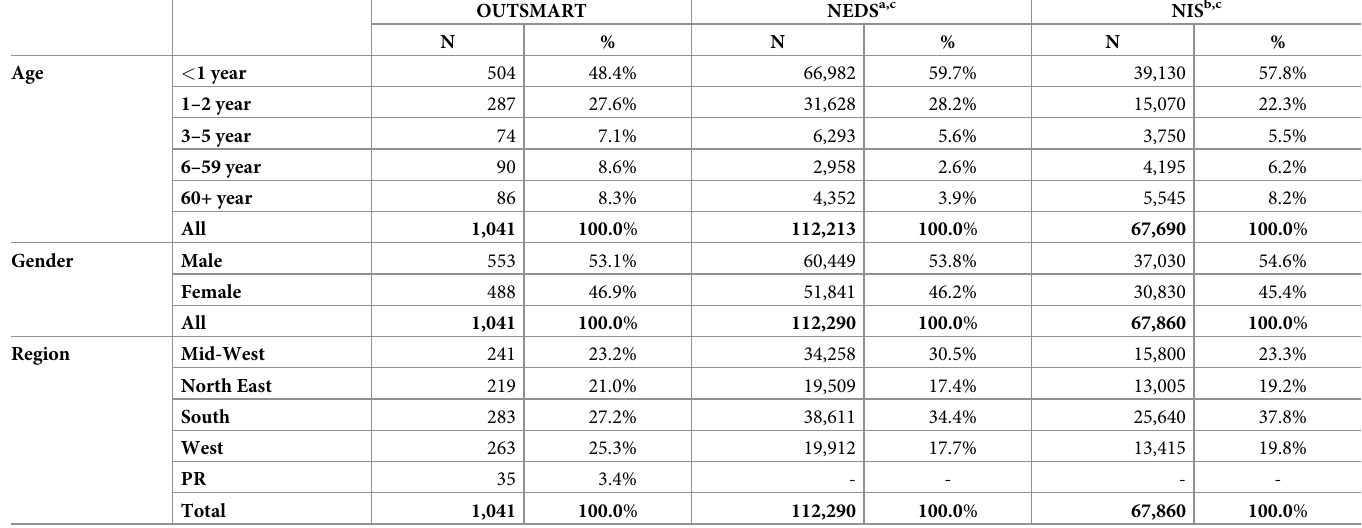
Table 1. Comparison of OUTSMART November 2016—March 2017 RSV positive tests with RSV in NEDS and NIS November 2013-March 2014 by age, gender and